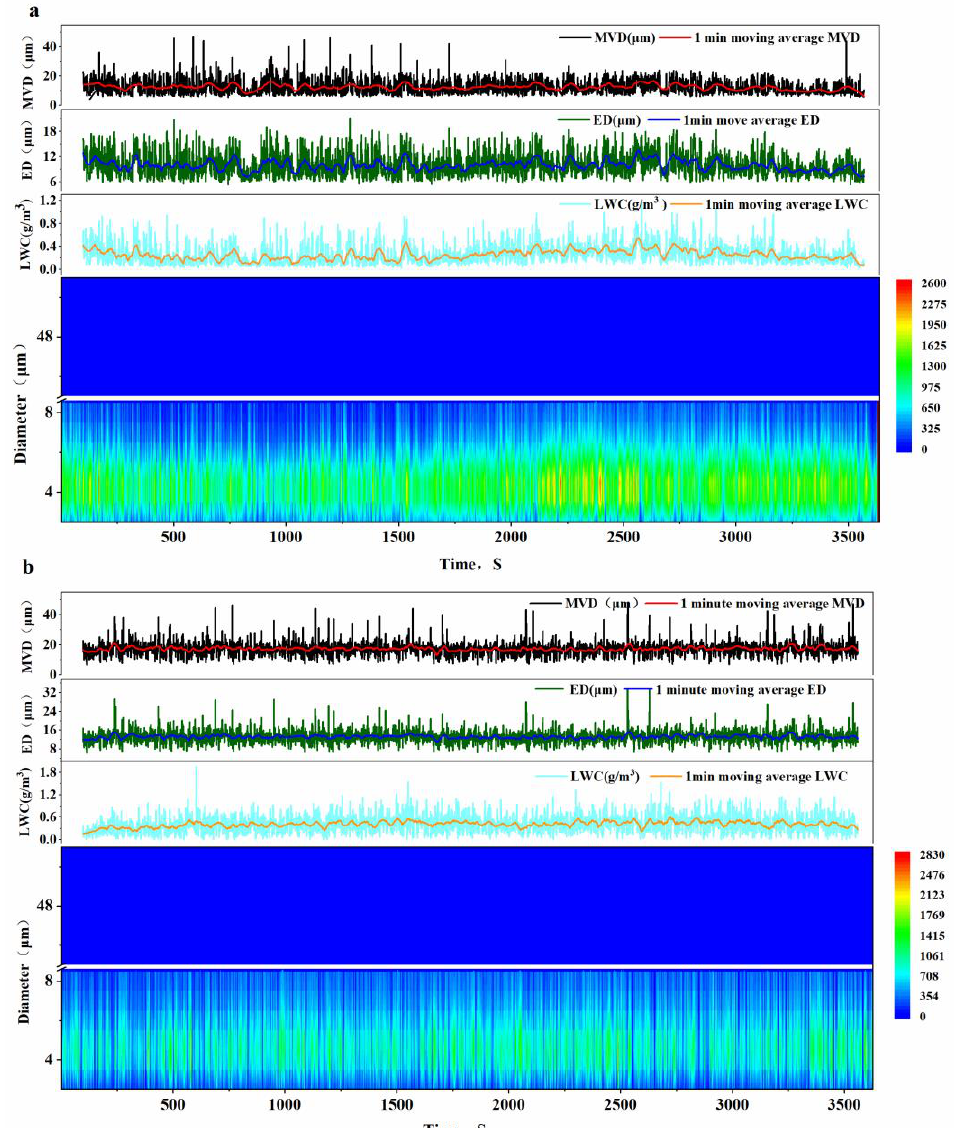
Figure 7. ED, MVD, LWC, and the relationship between Nc with fog droplet diameter at mean LWC of 0.25 g m − 3 ( a ) and 0.43 g m − 3 ( b ). Effective diameter (ED) represents the mean diameter of droplets, median volume diameter (MVD) represents the median diameter of droplets, and number concentration (N c ) represents the number of droplets in unit volume.